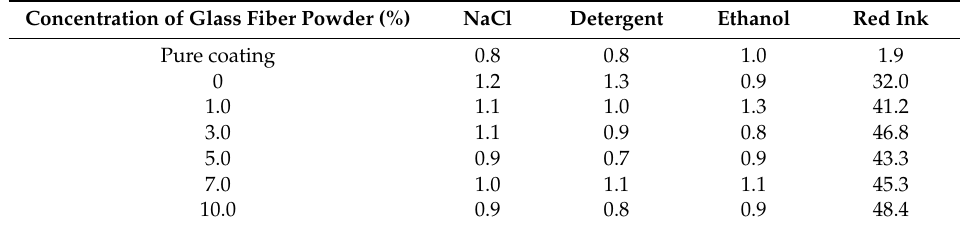
Table 7. E ff ect of glass fiber powder concentration on the color di ff erence of waterborne coatings with thermochromic ink for liquid resistance.